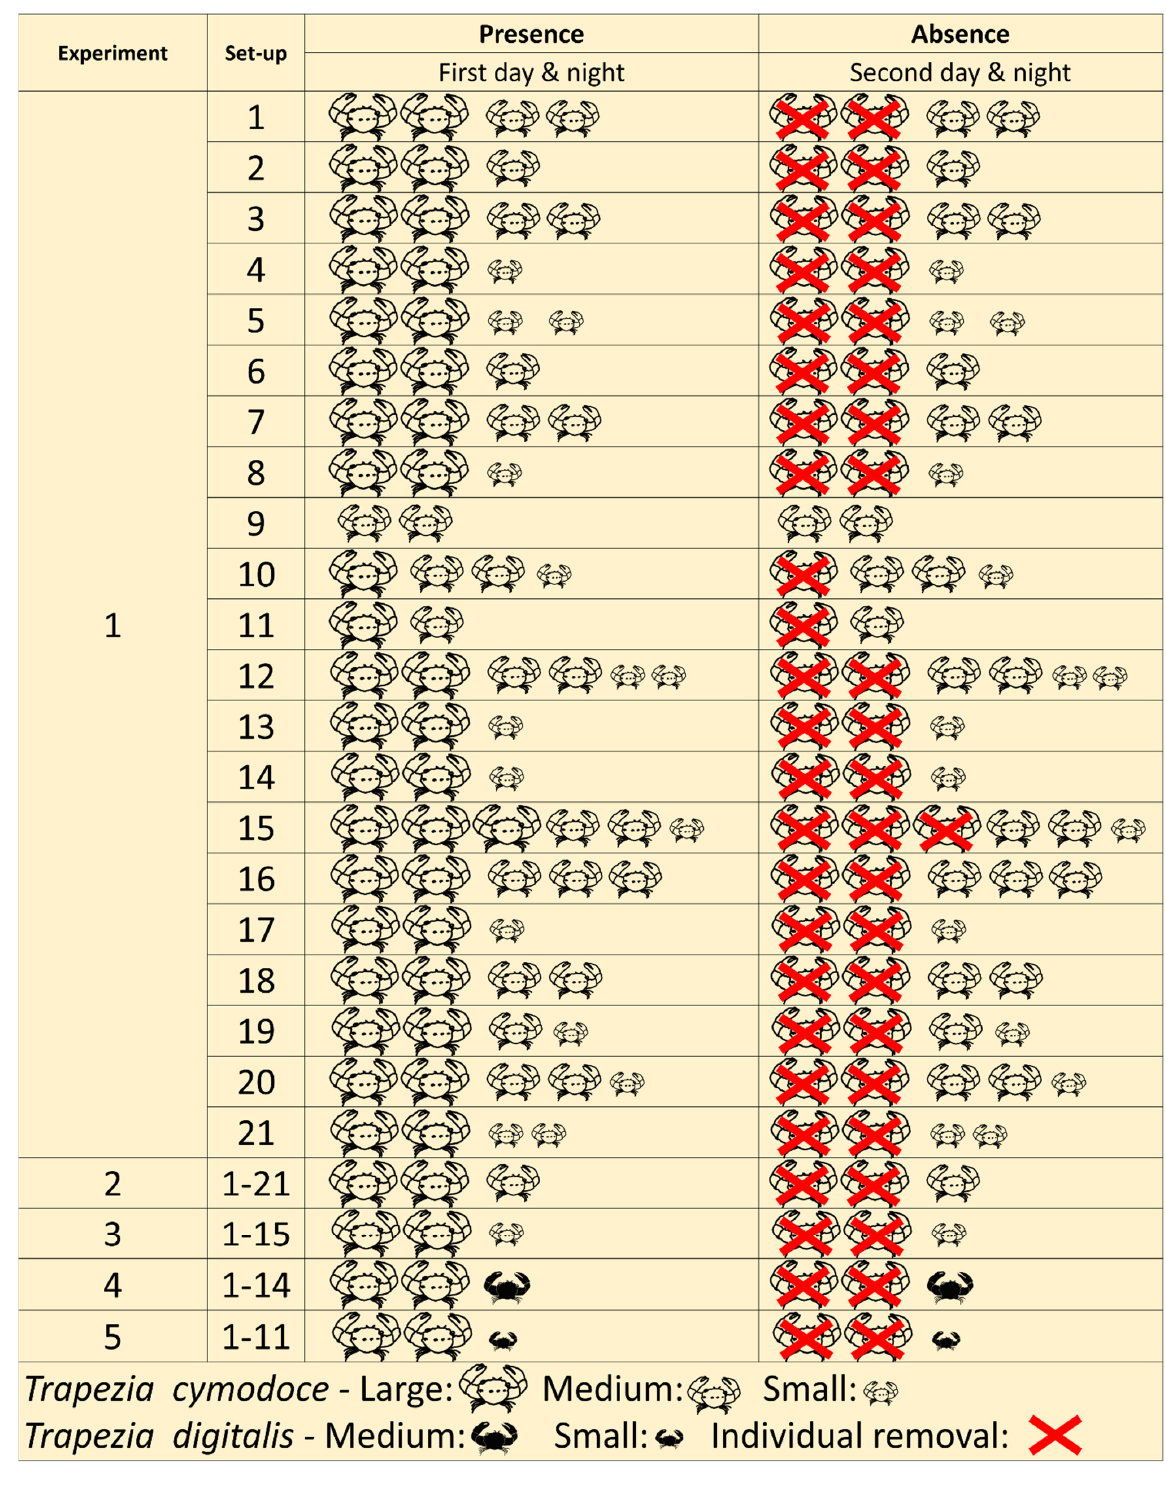
Figure 2. A pictograph presentation for lab experiments (1–5) design on the canopy compartmental usage by Trapezia crabs, managed by two basic scenarios: with the ‘presence’ or ‘absence’ of large pairs of Trapezia cymodoce .